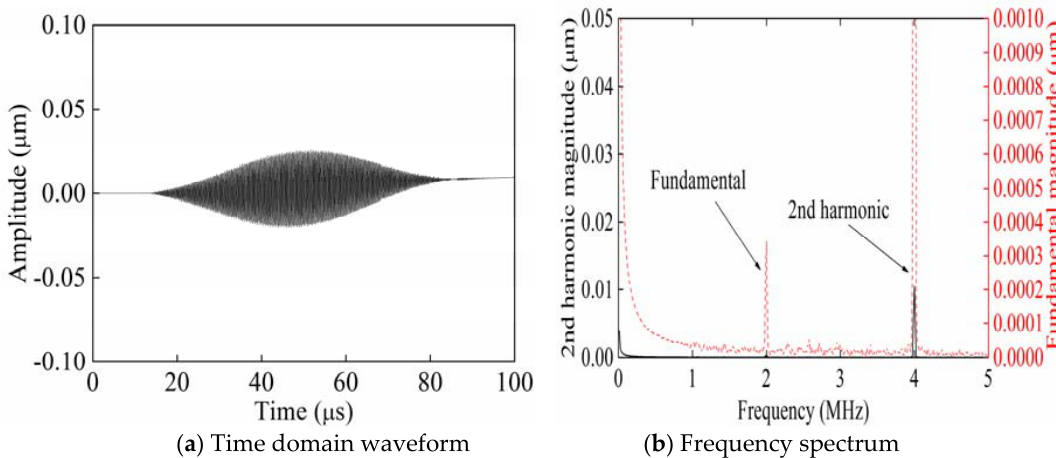
Figure 4. Time domain waveforms and frequency spectra of the received signals when synchronously separately exciting Rayleigh waves with phase angles of 0 ◦ and 180 ◦ from P 1 and P 2 .